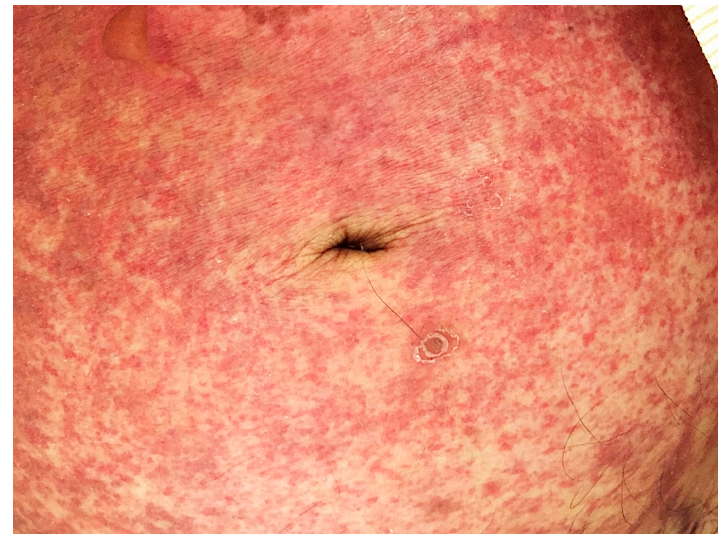
Figure 1. Case 1: Photograph of the peri-umbilical petechial abdominal rash.